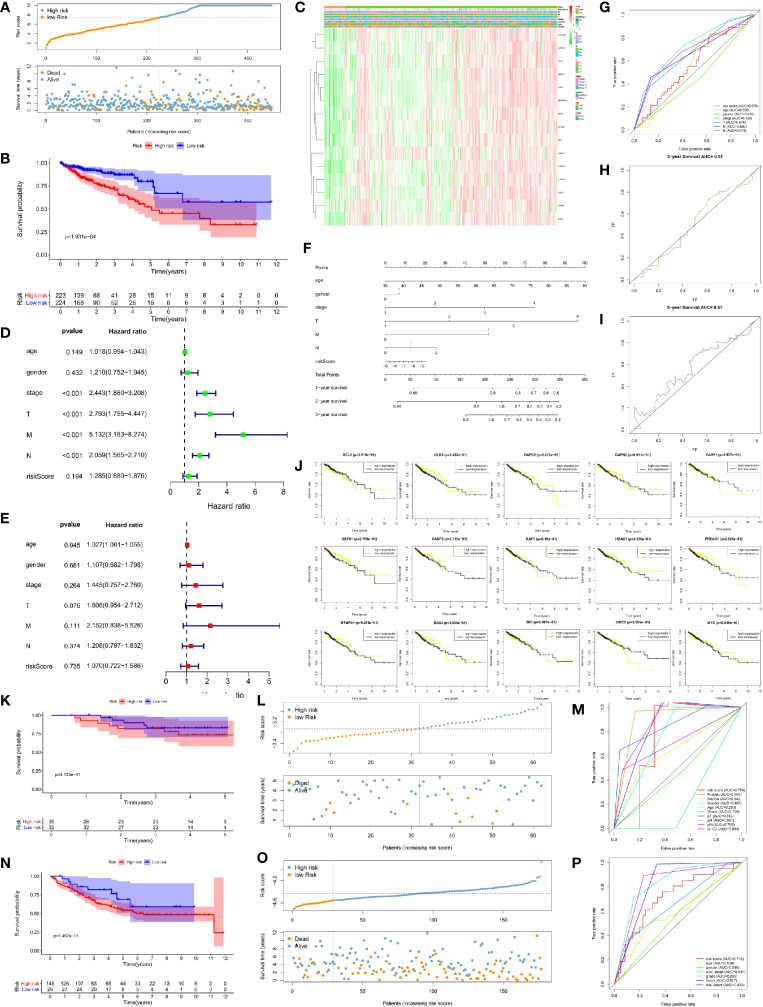
Risk prognosis model verification of 15 prognostic risk-related DEAGs in validation sets with the formula of risk model. (A) The distribution of risk score and the scatterplot of the relationship between risk scores and survival time in TCGA data by R package “ggplot.” (B) Survival curve comparing high-risk and low-risk groups in TCGA data by R package “survival.” (C) Heat map of prognostic DEAGs and clinical parameters at high-risk and low-risk groups in TCGA data by R package “pheatmap.” (D) The univariate cox forest map of clinical characteristics in TCGA data by R package “survival” and “forestplot.” (E) The multivariate cox forest plot of clinical characteristics in TCGA data by R package “survival” and “forestplot.” (F) The nomogram baseline of multivariate cox analysis in TCGA data by R package “rms.” (G) ROC curve of risk sore and other clinical characteristics in TCGA data by R package “survivalROC.” (H) ROC curve of 3-year survival in TCGA data. (I) ROC curve of 5-year survival in TCGA data by R package “survivalROC.” (J) The survival curve of 15 prognostic risk-related DEAGs expression in TCGA data by R package “survival.” (K) Survival curve comparing high-risk and low-risk groups in GSE12954 set by R package “survival.” (L) The distribution of risk score and the scatterplot of the relationship between risk scores and survival time in GSE12954 set by R package “ggplot.” (M) ROC curve of risk sore and other clinical characteristics in GSE12954 set by R package “survivalROC.” (N) Survival curve comparing high-risk and low-risk groups in GSE17536 set by R package “survival.” (O) The distribution of risk score and the scatterplot of the relationship between risk scores and survival time in GSE12954 set by R package “ggplot.” (P) ROC curve of risk sore and other clinical characteristics in GSE17536 set by R package “survivalROC.” *P < 0.05, **P < 0.01, ***P < 0.001, and ****P < 0.0001.